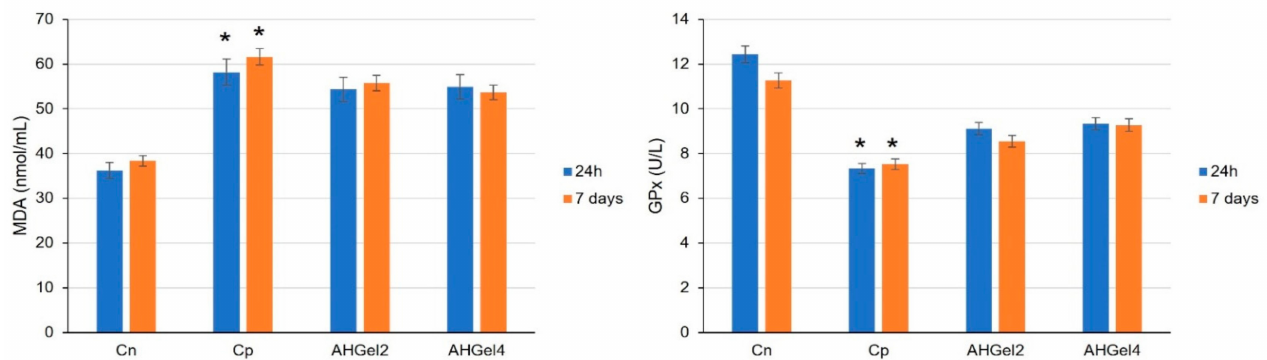
Figure 12. Effects of Amox-loaded hydrogels implantation on serum levels of MDA and GPx. For all data, the values are presented as mean ± S.D. * p < 0.05 reported to Cn.